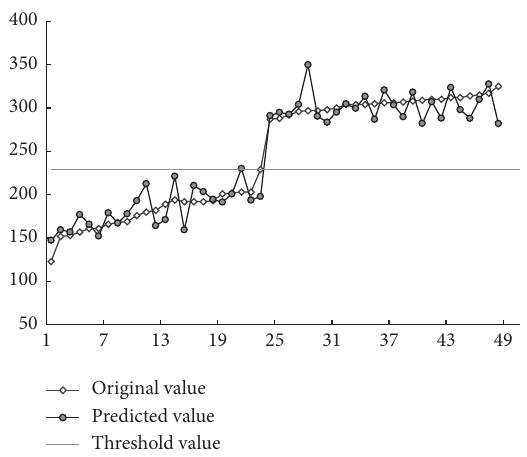
Figure 7: Comparison of the difference in delay time between the original and the predicted values.